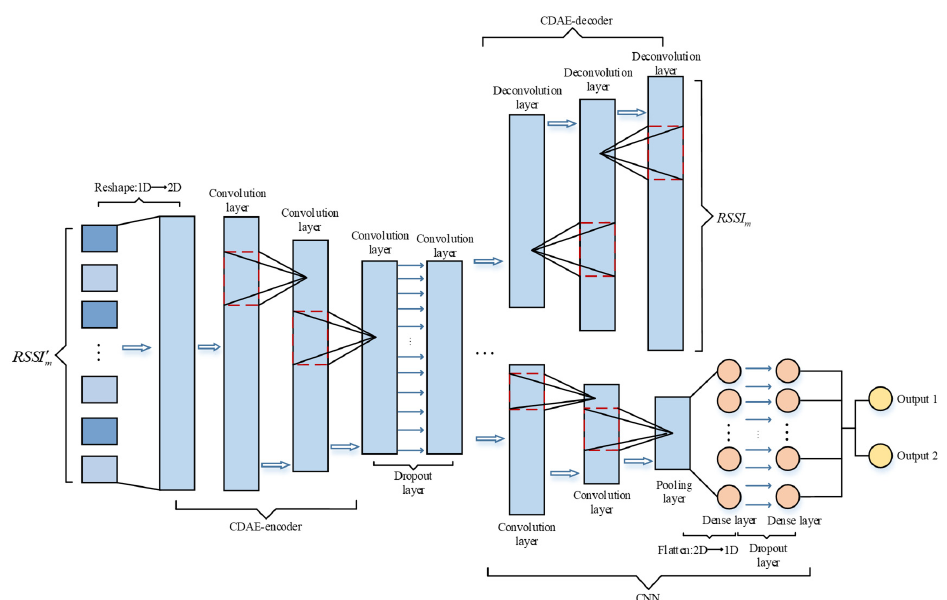
Figure 3. CDAE-CNN network structure.